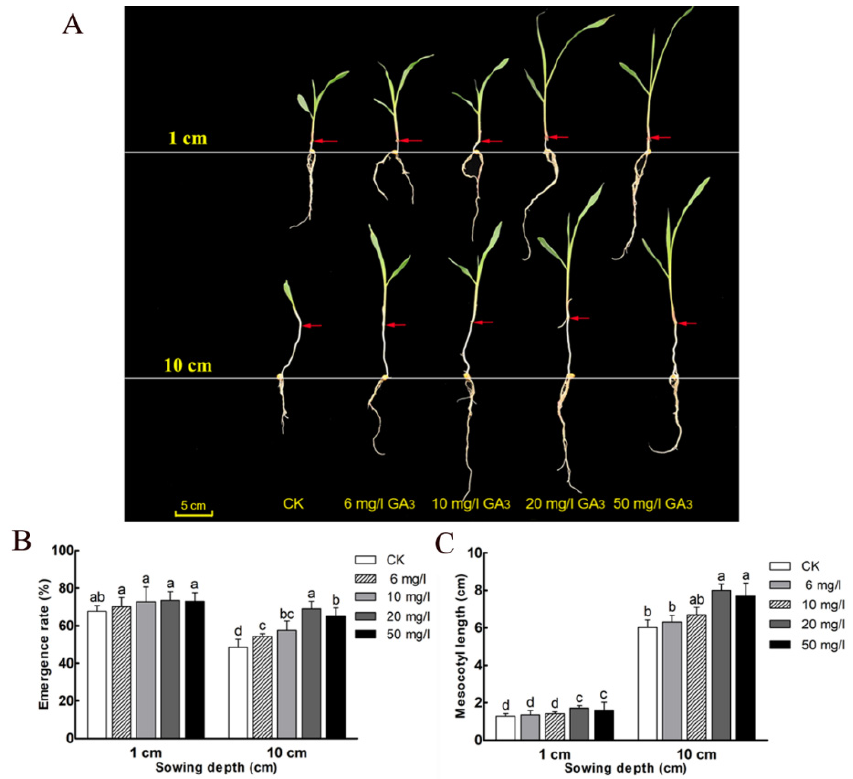
Figure 3. Morphological index ( A ), emergence rate ( B ), and mesocotyl length ( C ) of Ltx05 under different sowing depths (1 and 10 cm), treated with 0, 6, 10, 20 and 50 mg/l GA 3 for 7 days. Data are means ± SD of three replicates, and different letters indicate significant difference at p < 0.05.